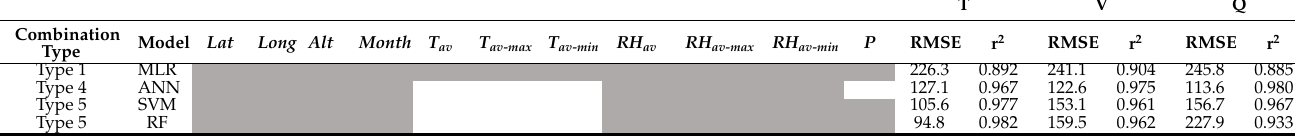
Table 2. Adjustment parameters for each best approximation model developed according to its selected input variables. Latitude ( Lat ), longitude ( Long ), altitude ( Alt ), month, average ( T av ), average of the maximum ( T av-max ) and the average of the minimum temperature ( T av-min ), average ( RH av ), the average of the maximum ( RH av-max ) and the average of the minimum ( RH av-min ) relative humidity and precipitation ( P ). RMSE is the root mean square error (10 kJ/(m 2 · day)) and r 2 is the squared correlation